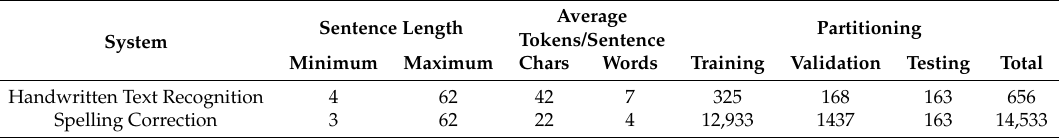
Table 5. Data distribution from Washington